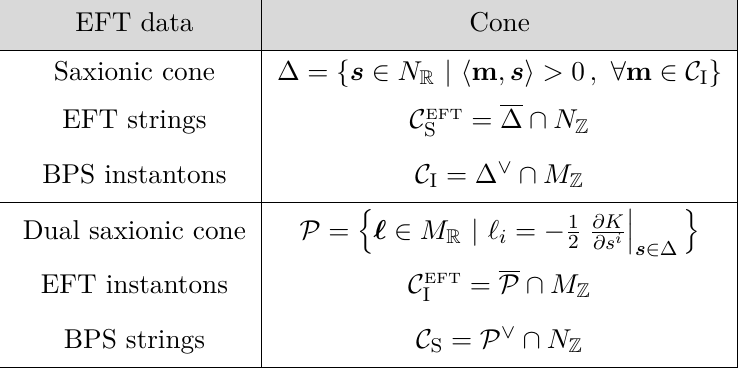
Table 1 . EFT conical structures induced by strings and